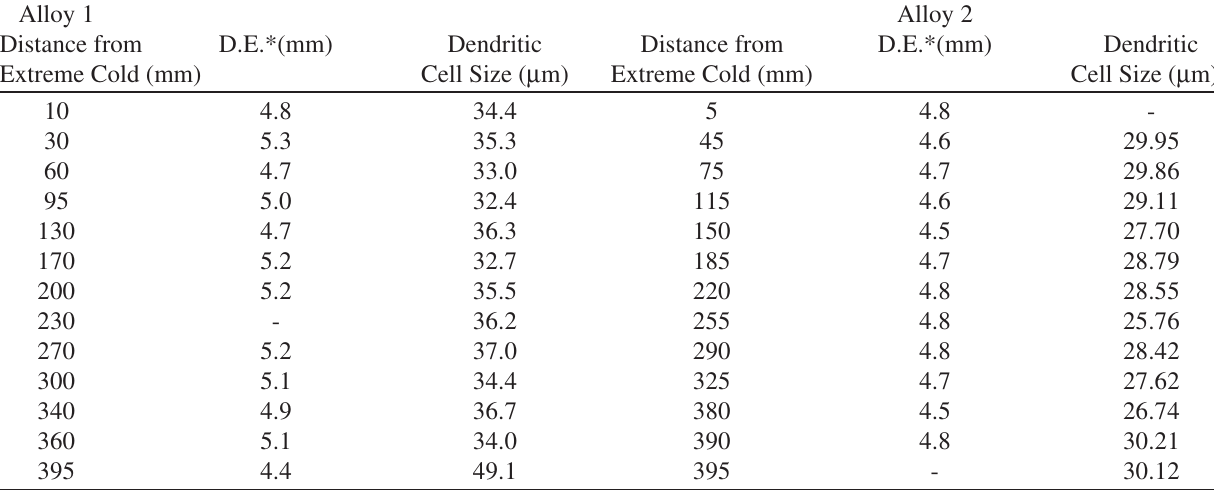
*D.E.: grain size in equivalent